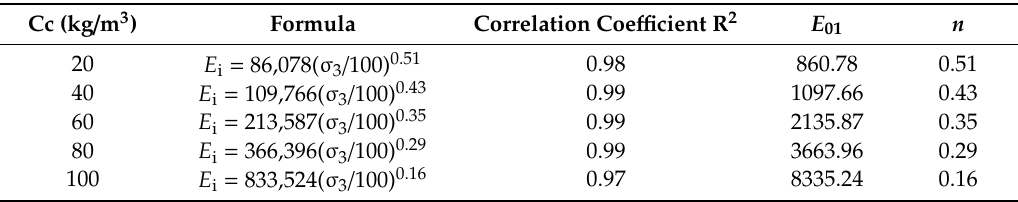
Table 4. Values of R 2 , E 01 , and n